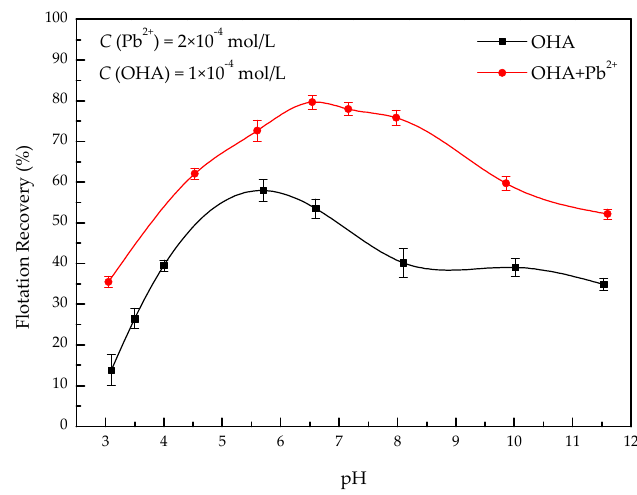
Figure 2. Effects of pH on perovskite flotation recovery in the absence and presence of Pb 2+ .